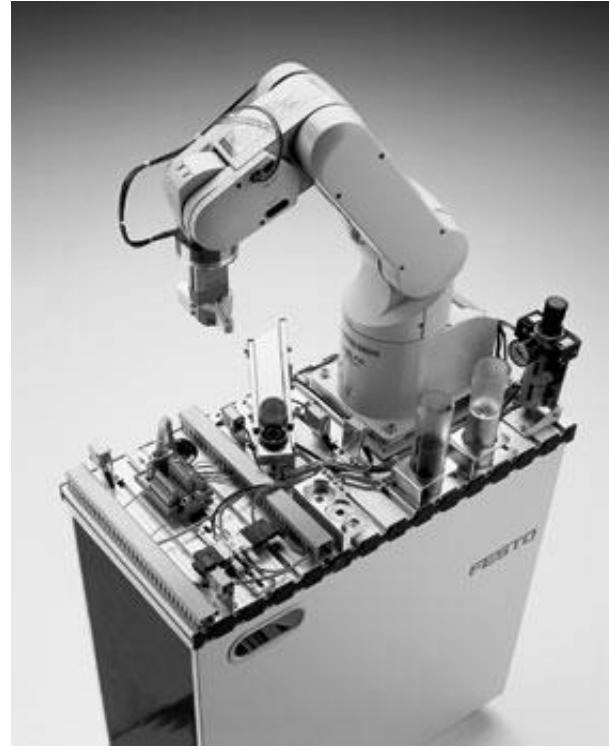
Figure 4. Appearance of the modular production